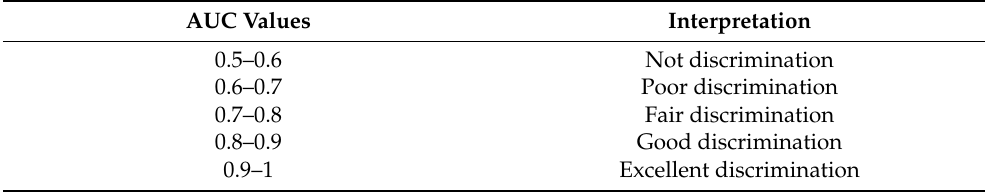
Table 1. Discrimination accuracy of ROC–AUC (adapted from